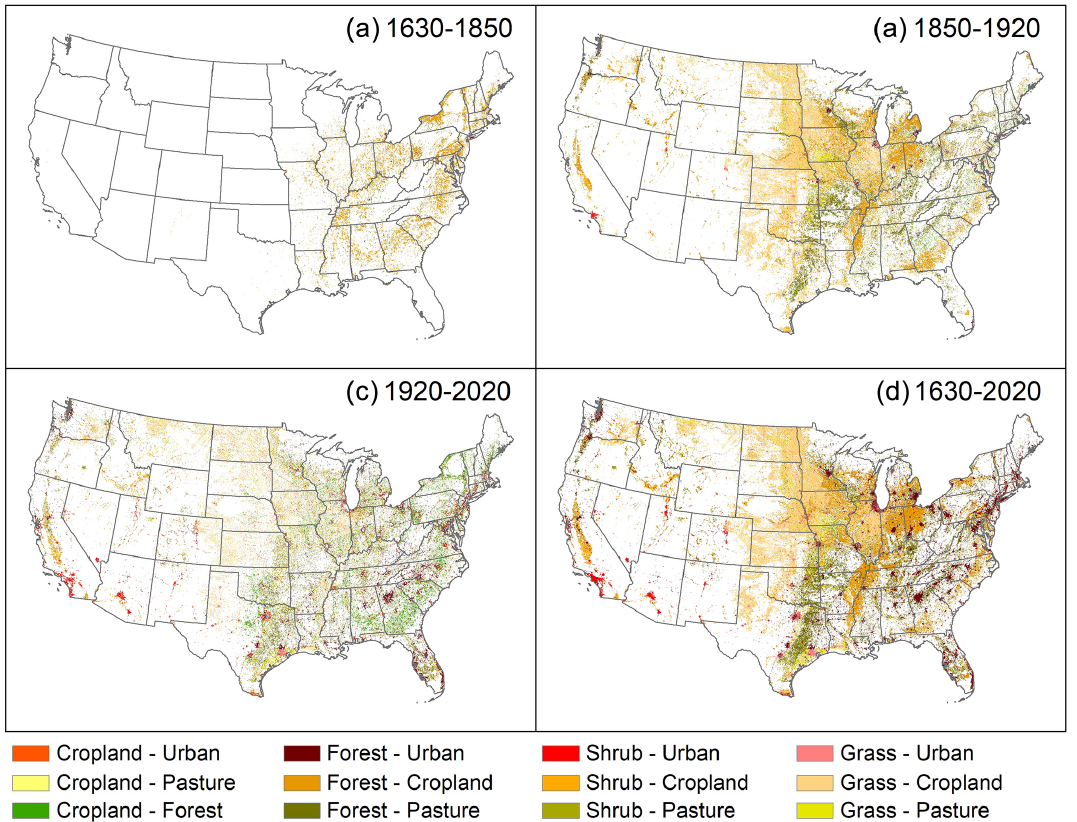
Figure 7. Land transition (1km × 1km spatial resolution) between 1630 and 1850 (a) , 1850 and 1920 (b) , 1920–2020 (c) , and 1630 and 2020 (d) in the conterminous United